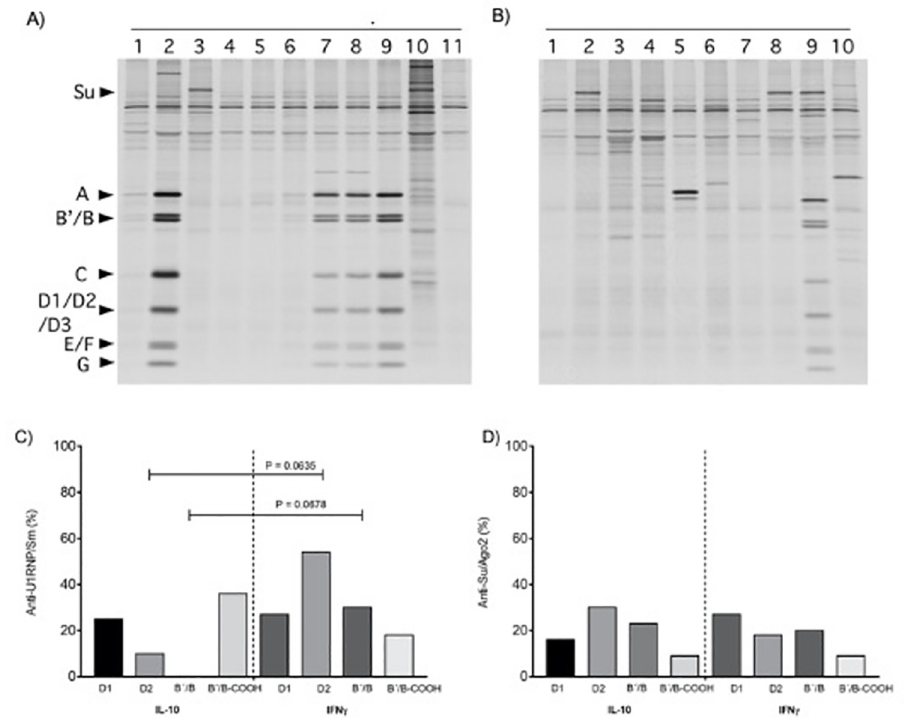
Fig 2. Immunoprecipitation using sera from pristane-treated mice co-vaccinated with D2 plus IFN- γ vs . IL-10. 35 S-methionine-labeled K562 cell extract was immunoprecipitated using sera from pristane-treated mice. Panel A) IFN- γ /D2 co-vaccinated group: anti-nRNP/Sm (A, B´/B, C, D1/D2/D3, E/F, and G) antibodies are observed in lanes 2,7,8 and 9, and anti-Su (100kDa) in lane 3 and 10. Panel B) IL-10/D2 co-vaccinated group: anti-nRNP/Sm (A, B´/B, C, D1/D2/D3, E/F, and G) is observed in lane 9 and anti-Su antibodies in lanes 2,8, and 9. Panel C) Prevalence of anti- nRNP/Sm antibodies. Panel D) Prevalence of anti-Su/Ago2 antibodies. The results are shown in percentage (%, Wilcoxon rank-sum